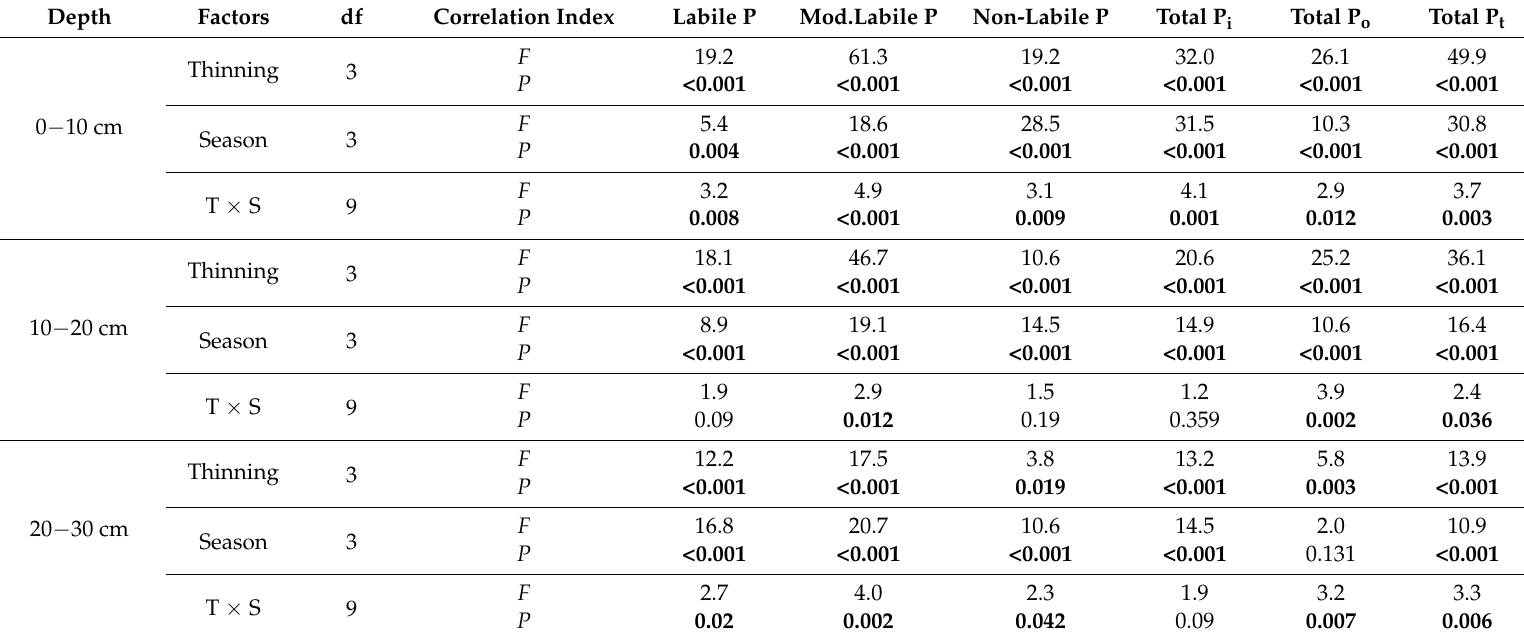
Table 3. Repeated-measures ANOVA for soil P fractions in four thinning treatments from April to October 2017 in L. principis-rupprechtii plantations.